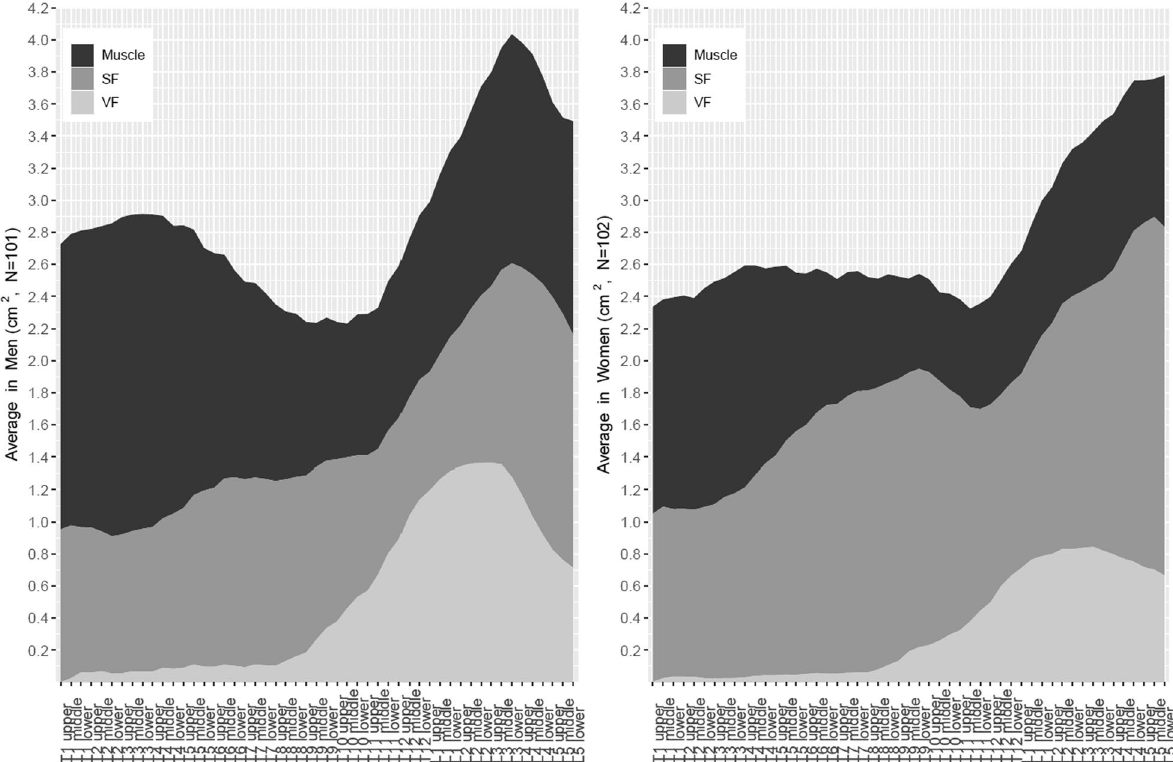
Fig. 3 Averaged cross‑sectional areas of muscle, subcutaneous fat (SF), and visceral fat (VF) at thoracolumbar levels in both